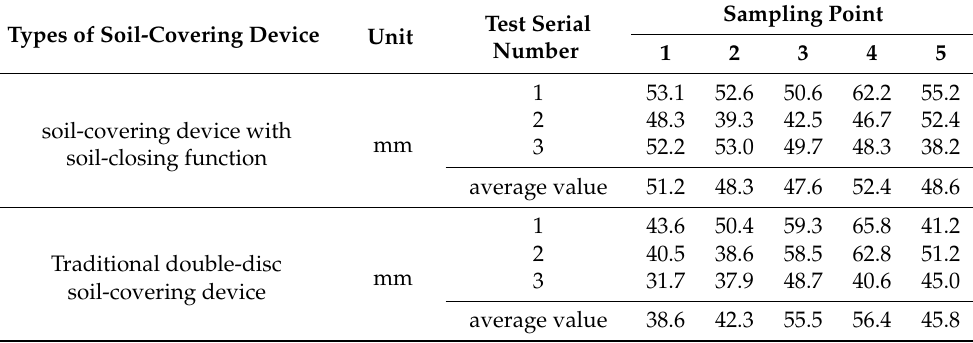
Table 6. The measurement results of the difference in the thickness of the covering soil at the sampling